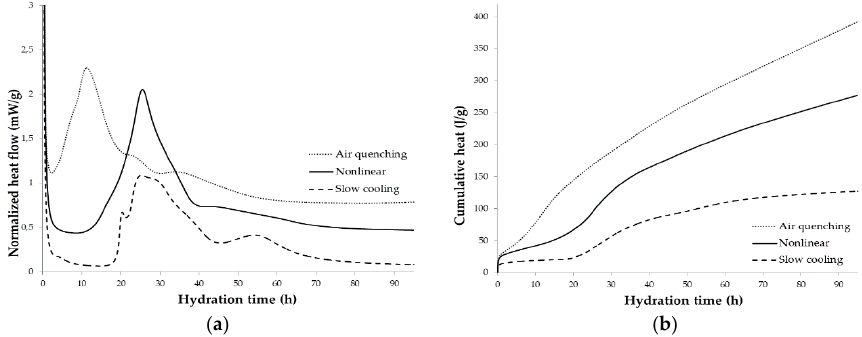
Figure 8. Hydration heat flow ( a ) and the development of cumulative heat of hydration ( b ) for the cement clinkers under varying cooling regimes.